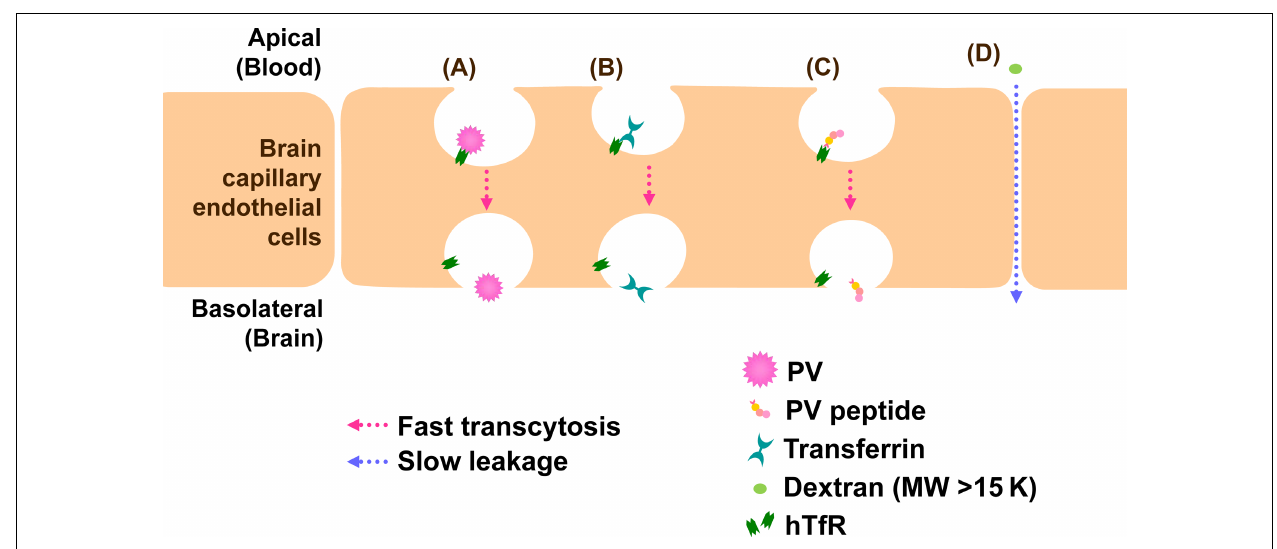
FIGURE 3 | Models for BBB permeation of PV. TfR1 attaches to PV (A) , transferrin (B) , or PV peptide (C) and transported through brain capillary endothelial cells into brain by a fast process. On the other hand, dextran (MW > 15 K) is not transcytosed byTfR1 and leaks between cell junctions by a slow process (D)